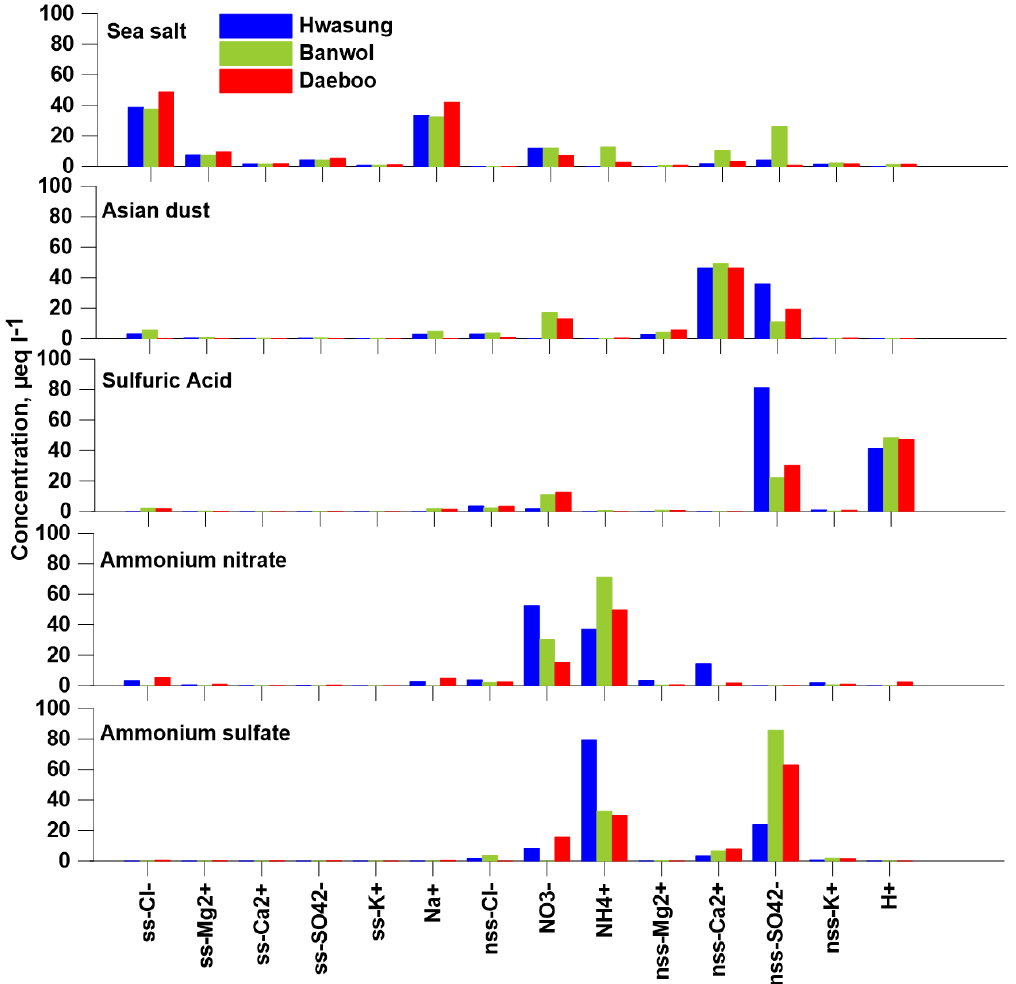
Figure 7. Source contributions of factors 1–5 at the three stations.